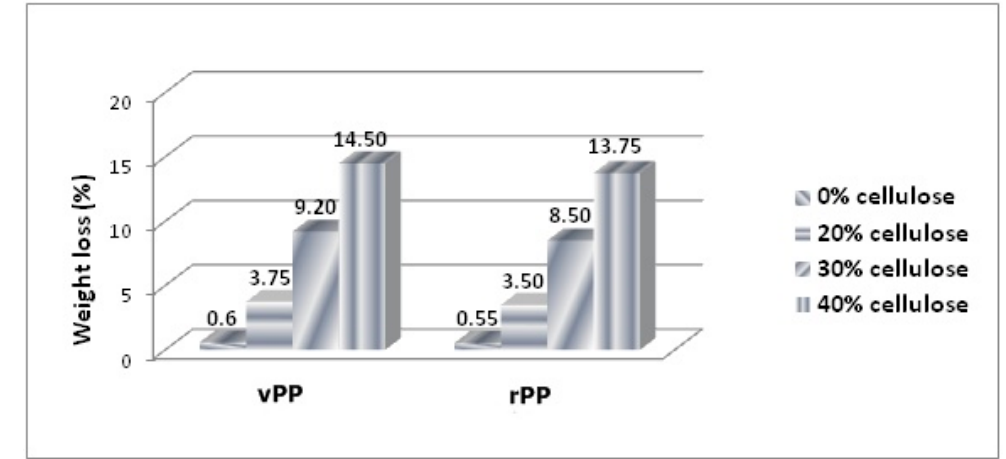
Figure 2. Weight loss of composites after 24 months of soil burial.